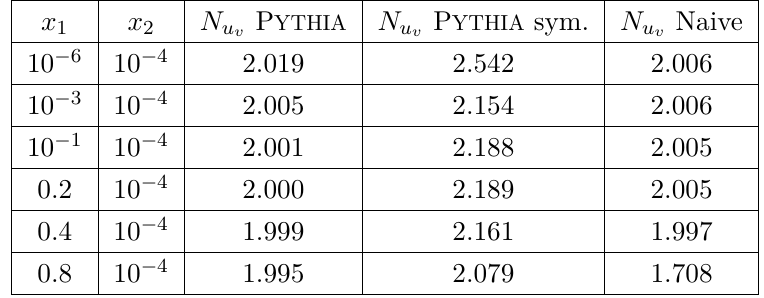
response function. In the ideal uuu = 0 . v 2